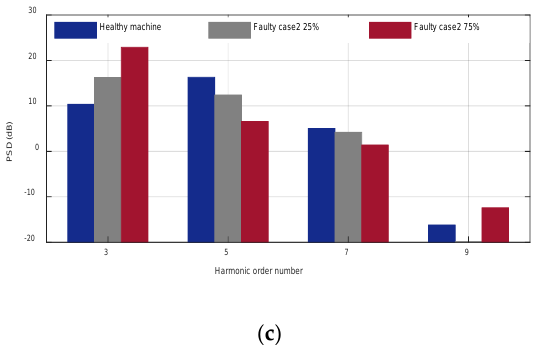
Figure 24. Faulty case 2: ( a ) PMSM current spectra normalized plot under 25%; ( b ) PMSM current spectra normalized plot under 75%; ( c ) ASBCs harmonics variations.